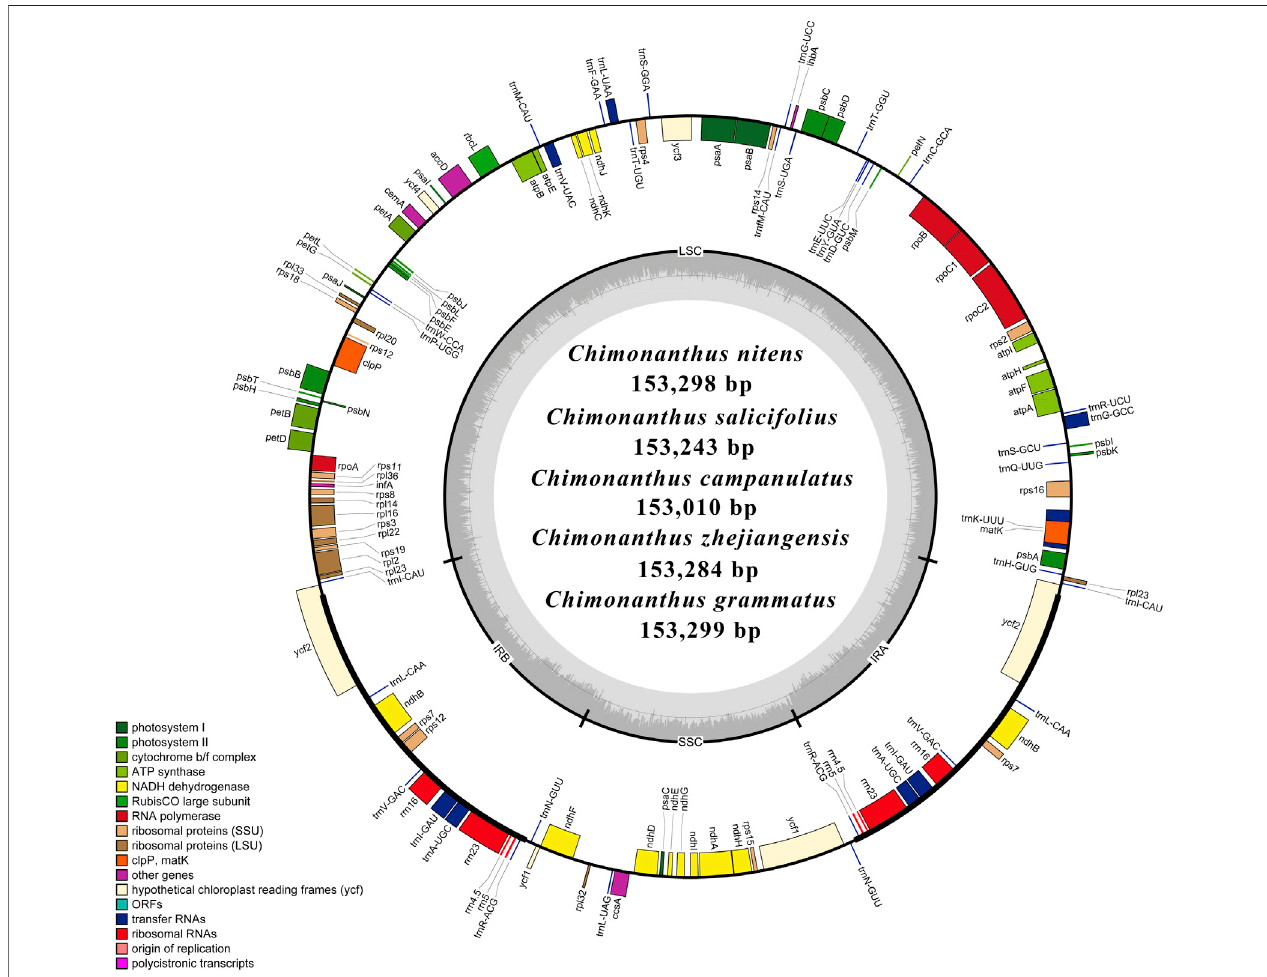
FIGURE 1 | Schematic representation of the de novo assembled circular chloroplast genomes of fi ve Chimonanthus species. Genes present inside the circle are transcribed counterclockwise, whereas genes present outside the circle are transcribed clockwise. Genes are color-coded based on their role in different pathways, as giveninthekey.Largesinglecopy(LSC),invertedrepeatb(IRb),smallsinglecopy(SSC),andinvertedrepeata(IRa)oftheinnercirclerepresentquadripartitestructureof cp genomes. Dark grey area in the inner circle represents average guanine – cytosine (GC) content, while light grey represents AT content.